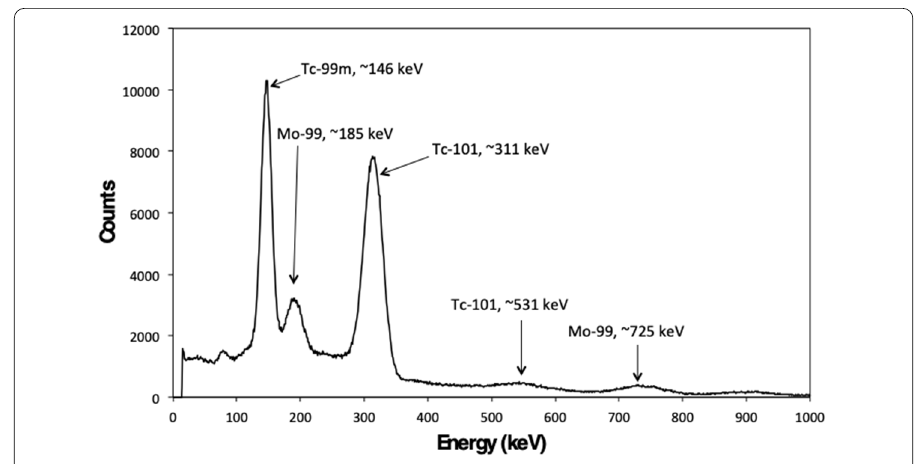
Figure 4 Gamma spectrum of Mo cube after ∼ 1.4 h post EOB showing characteristic peaks for 99 Mo, 99 m Tc, and 101 Tc after being irradiated in a neutron field for ∼ 4.6